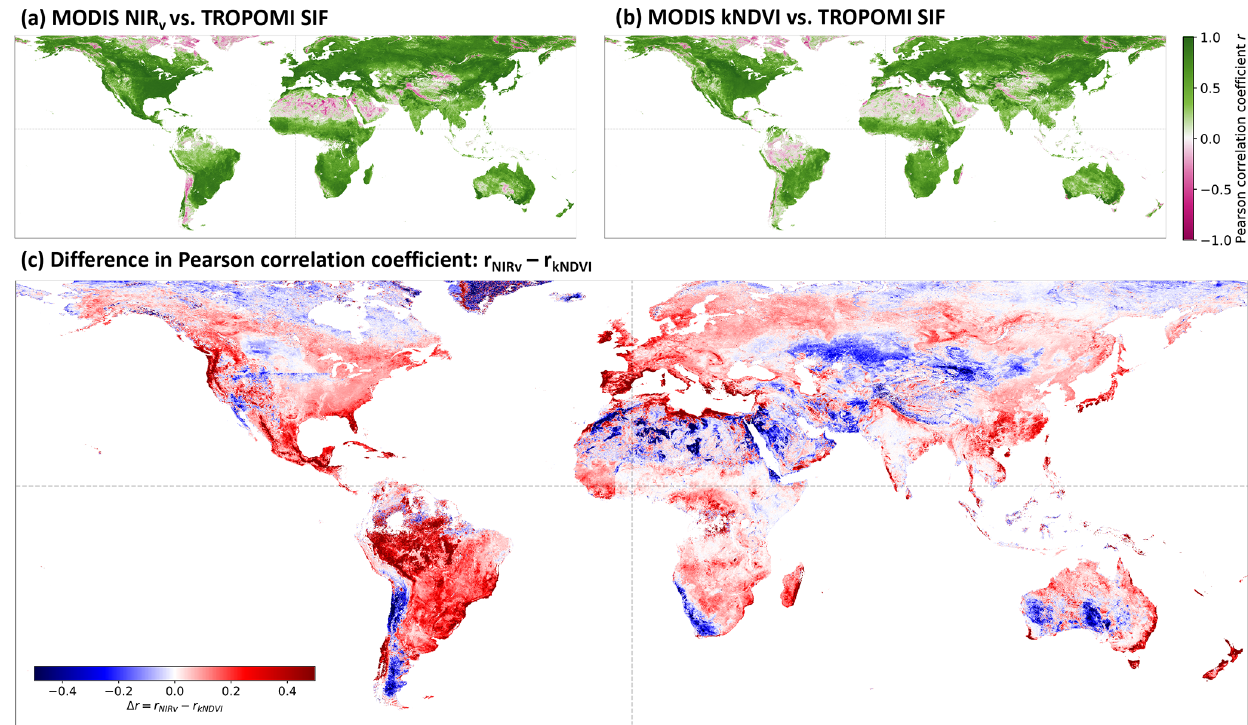
Figure 2. Pearson correlation coefficient of NIR v and kNDVI to TROPOMI SIF. Data are compared at 0.05 ◦ spatial resolution and in 16d time steps starting in April 2018 until March 2021. The value per grid cell in (a) and (b) represents the Pearson correlation coefficient of the vegetation index to SIF in time. Panel (c) represents the difference in correlation of the vegetation indices to